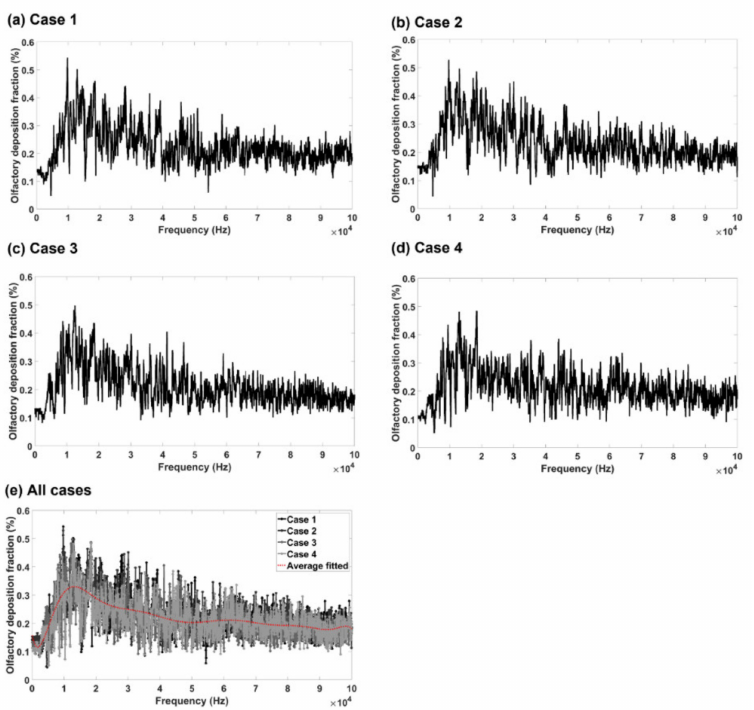
Figure 5. Comparison between obtained results of frequency analysis of ( a ) Case 1, ( b ) Case 2, ( c ) Case 3, ( d ) Case 4, and ( e ) all cases with an average line.